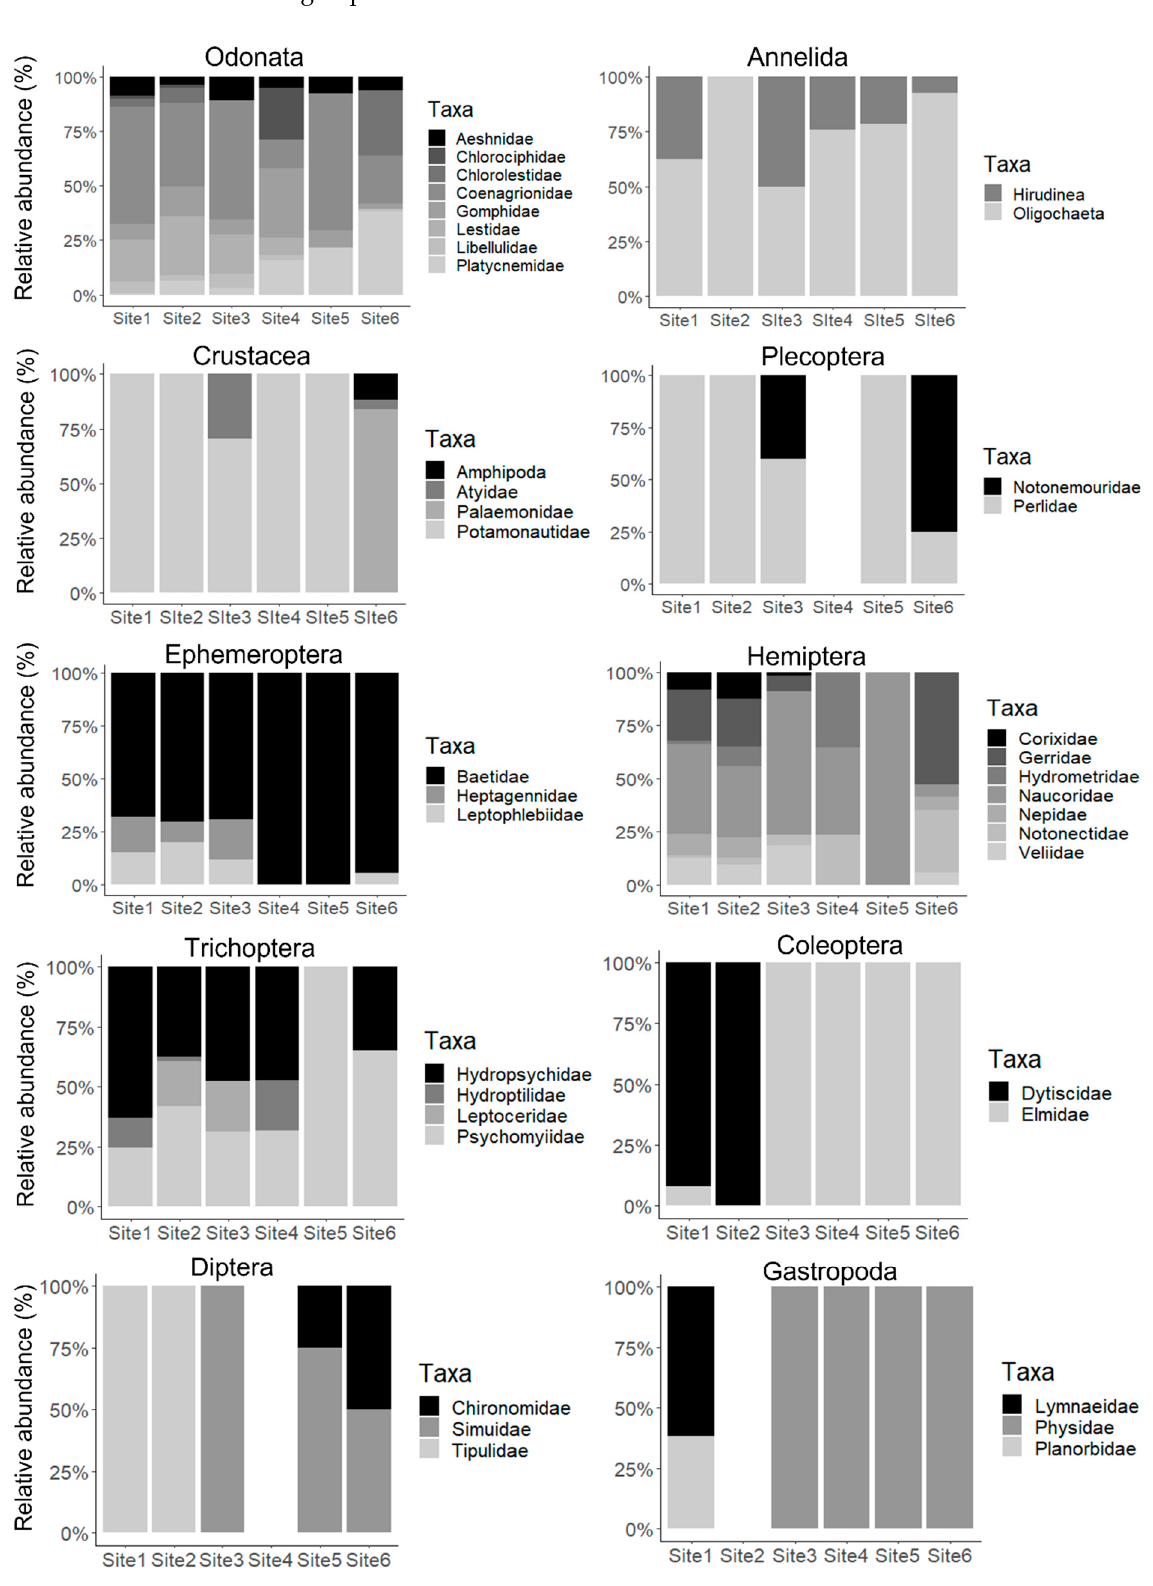
Figure 3. Taxa recorded in the Palmiet River during 2017 to 2018 surveys.